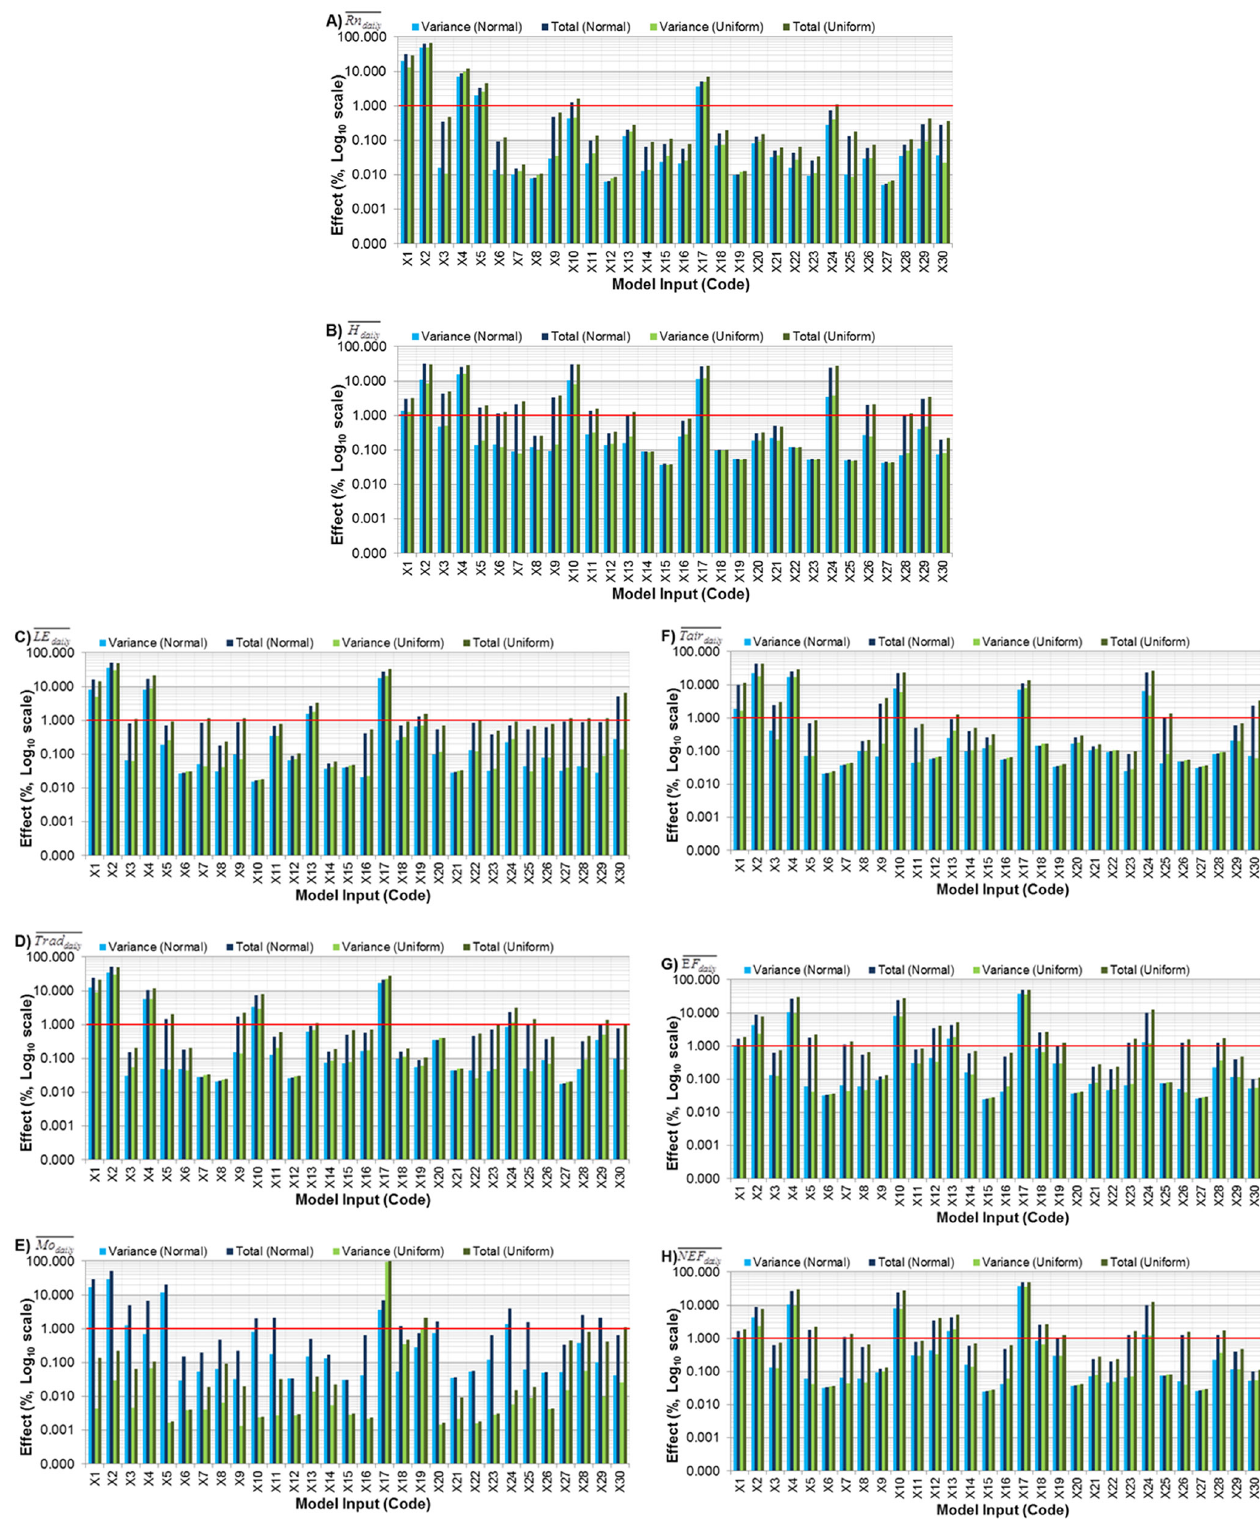
Figure 3. Variance decomposition and total effects of the model inputs examined for (A) Rn daily , (B) H daily , (C) LE daily , (D) Trad daily , (E) Mo daily , (F) Tair daily , (G) EF daily and (H) NEF daily . Vertical axis is logarithmic (Log 10 ) , with the horizontal red line at 1% signifying those parameters that are highlighted in Tables 3 and 4. The definitions of the parameters in x axes have been provided in Table